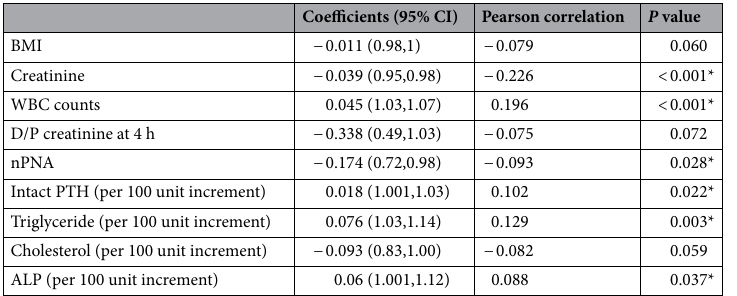
Table 3. Multiple linear regression coefficients and Pearson correlation of globulin with various clinical parameters. BMI body mass index, WBC white blood cells, PTH parathyroid hormone, ALP alkaline phosphate, nPNA normalized protein nitrogen appearance, D/P creatinine dialysate-to-plasma creatinine ratio. * p <